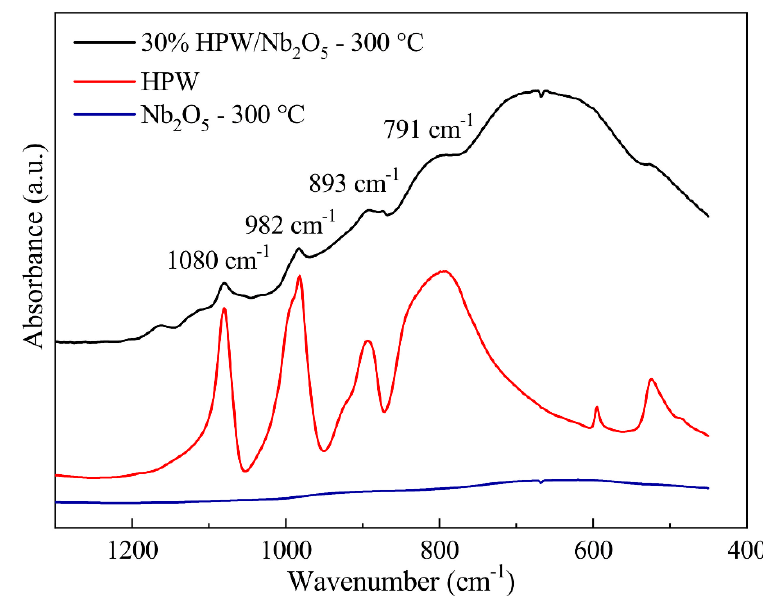
Figure 2. FTIR spectra of the heteropolyacid (HPW) active phase, Nb 2 O 5 support, and HPW/Nb 2 O 5 catalyst.